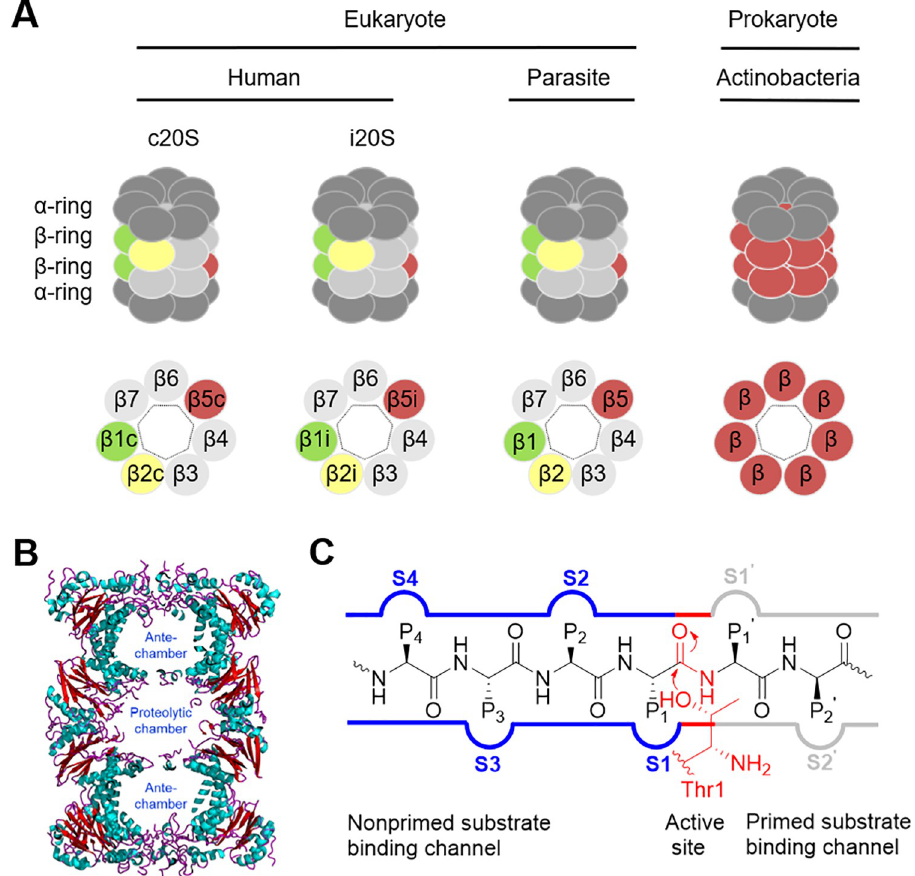
Fig 2. Illustration of 20S proteasomes of eukaryotes and prokaryotes. (A AU : PleasenotethatfigurepartAhasbeenaddedatthebeginningofthesentence 20 Sproteasomesarehighlyconservedinstructurefrombacteriato ::: inFig 2 caption : Pleaseconfirmthatthisiscorrect : ) 20S proteasomes are highly conserved in structure from bacteria to humans. Each 20S proteasome consists of 14 α subunits and 14 β subunits, organized as a barrel-shaped compartmentalized protease with α and β subunits in α 7 β 7 β 7 α 7 order. Outer rings are composed of α subunits and inner rings of β subunits. Only β subunits are proteolytically active in prokaryote proteasomes, and only β 1, β 2, and β 5 are proteolytically active in eukaryotic proteasomes. (B) Three chambers are formed in each 20S proteasome. The 2 outer chambers formed by α rings abutting the β rings are proposed to prevent unfolded protein substrates from refolding again prior to hydrolysis in the proteolytic chamber. (C) Substrate binding cleft located at the β subunits. The nucleophilic hydroxy group of the N-terminal Thr 1N at β of prokaryotic 20S proteasomes and β 1, β 2, and β 5 of eukaryotic 20S proteasomes attacks the amide bond at the preferred site of a protein substrate.